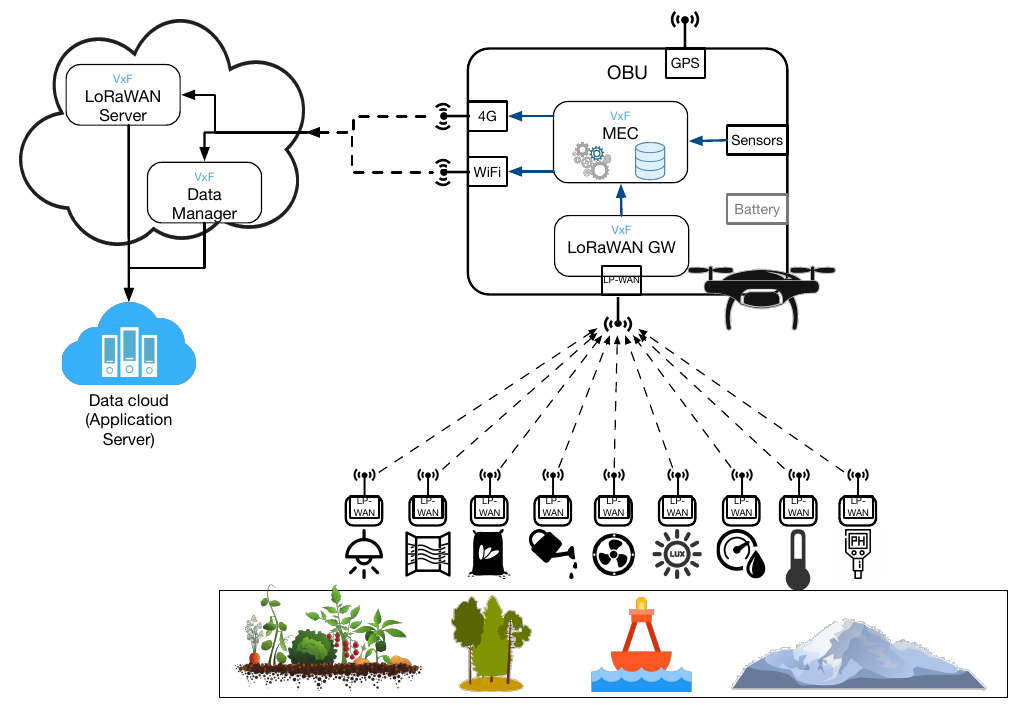
Figure 1. General architecture of the LoRa Wide Area Network (LoRaWAN) connectivity and Multi-Access Edge Computing (MEC) processing solution.